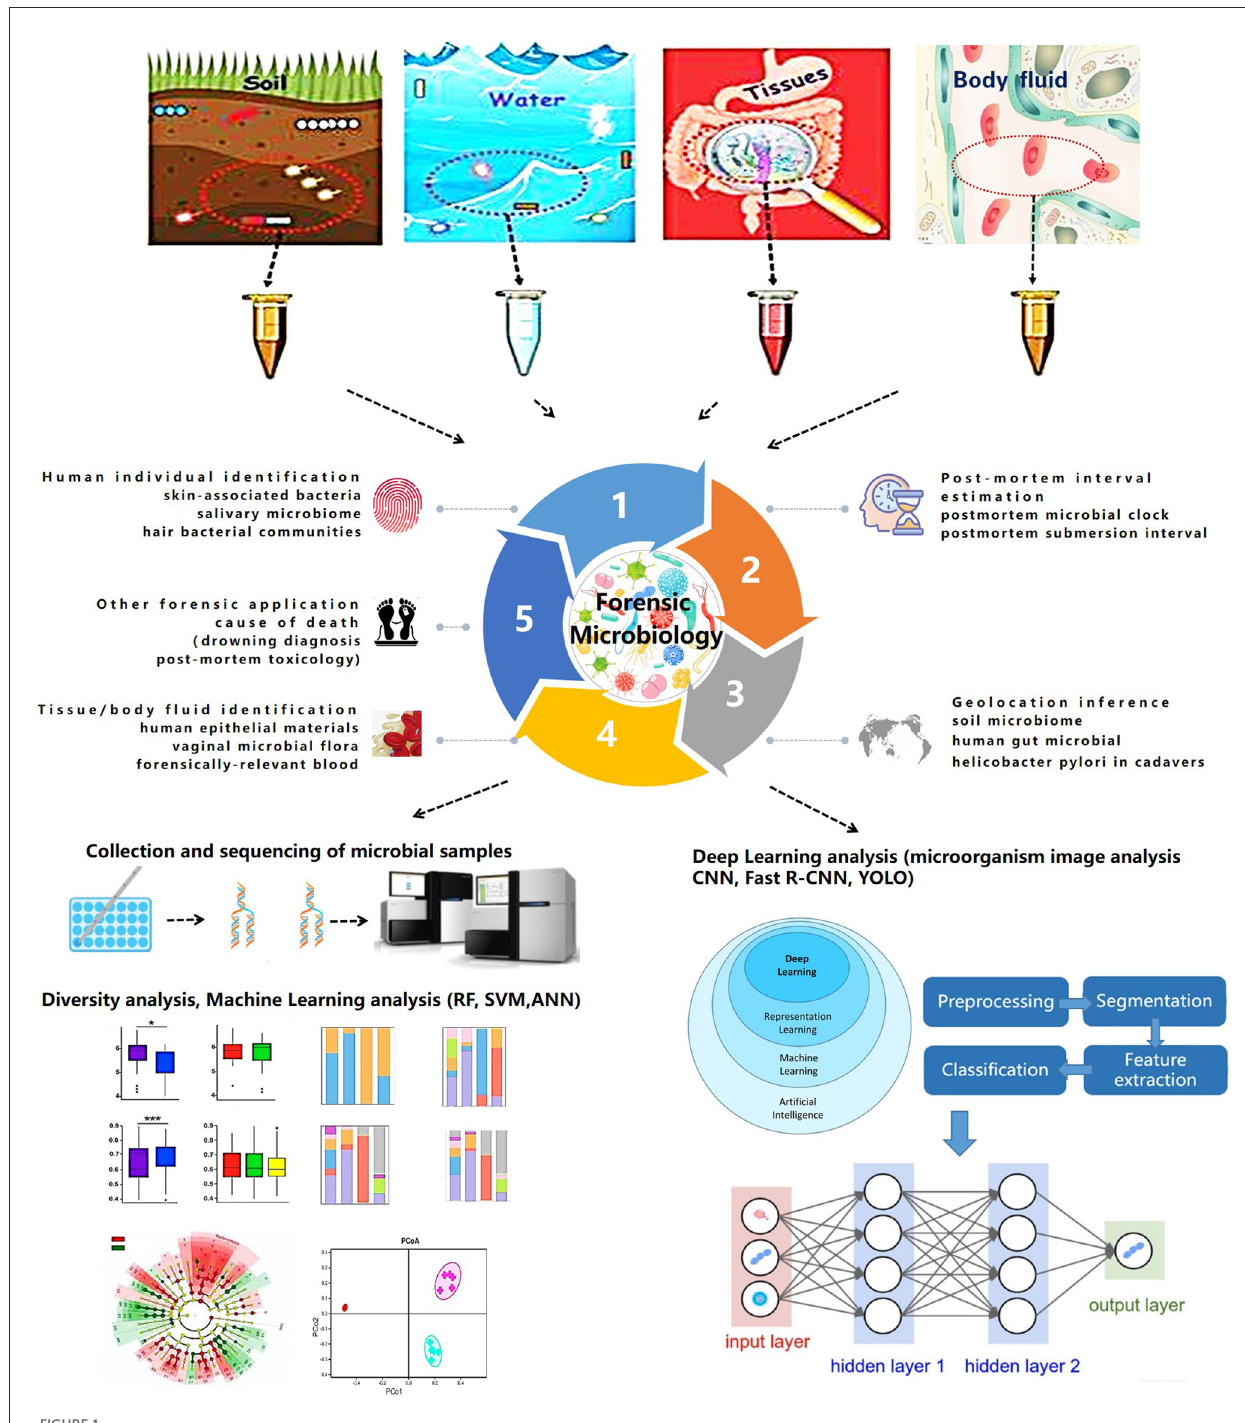
FIGURE1 Trends in forensic microbiology.